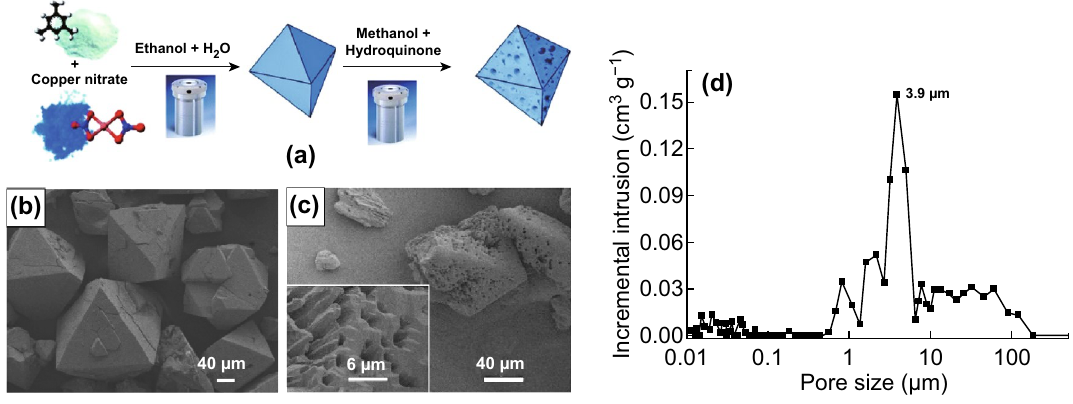
Fig. 11 a Schematic representation for the preparation of HKUST-1 particles and the subsequent modification to produce macroporous HKUST-1 particles. b SEM image of HKUST-1 microparticles prepared by solvothermal synthesis with water–ethanol (1:1 v/v). c SEM image of modified HKUST-1 particle with hydroquinone at 150 °C for 16 h, showing the macroporous microparticles. d Macropore size distribution as measured by Hg intrusion porosimetry, with an intrusion pore volume 2.65 cm 3 g −1 , for the modified HKUST-1 particles. Reprinted with per- mission from Ref. [95]. Copyright 2014 Royal Society of